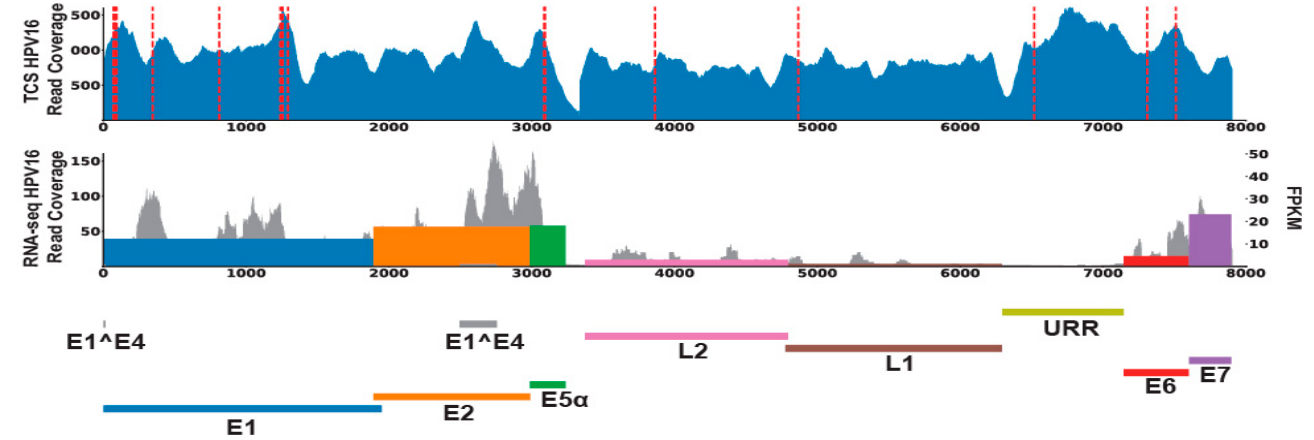
Figure 2. HPV16 DNA and RNA content in MEC1. The read coverages of HPV for MEC1 were filled in blue (first lane) for targeted capture sequencing data; grey for RNA-seq data (second lane). Red dashed lines denoted the HPV-host integrations called from targeted capture sequencing data. HPV genes expression levels (FPKM) were marked as colored bars in the second lane.